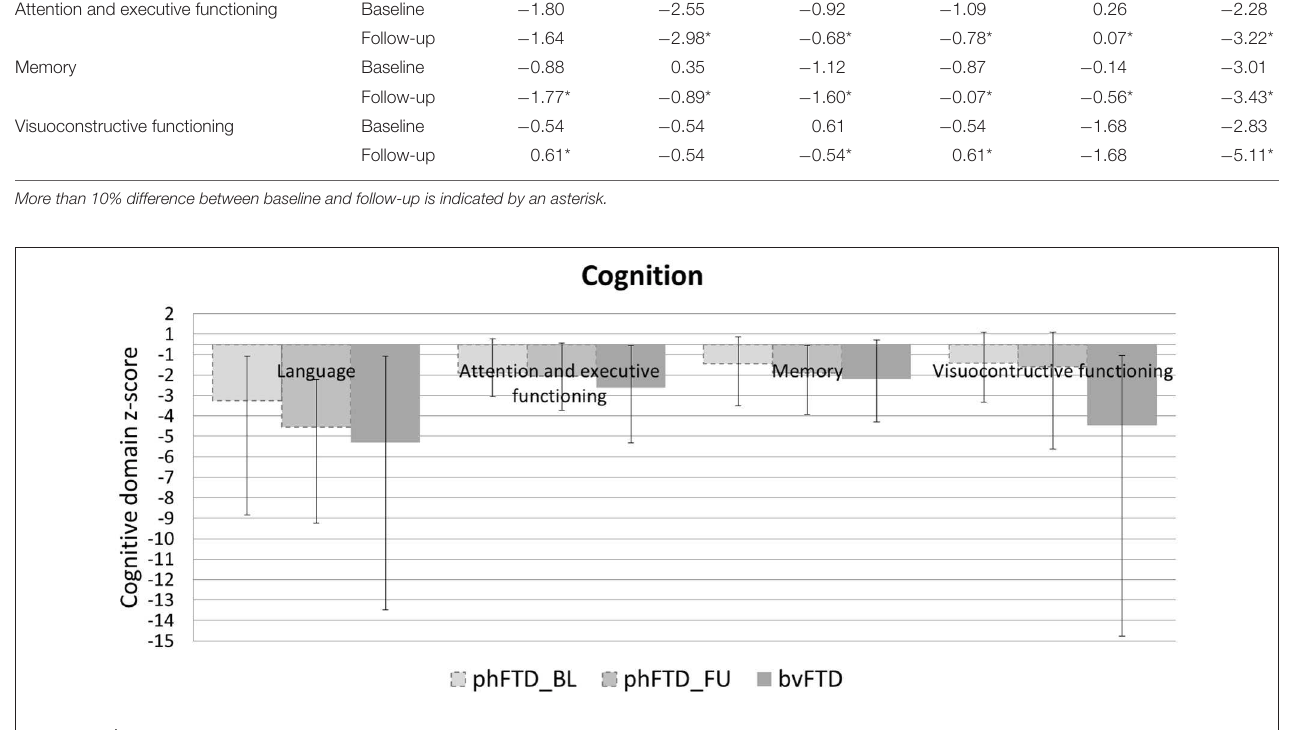
Frontiers in Neurology |